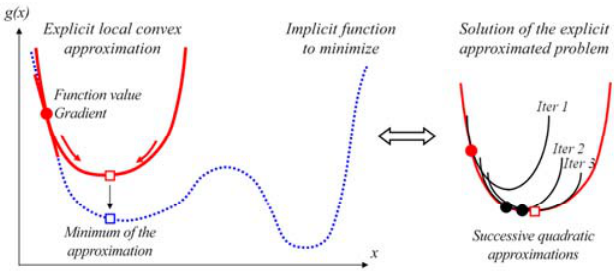
Fig. 4. Illustration of the Sequential Convex Programming approach